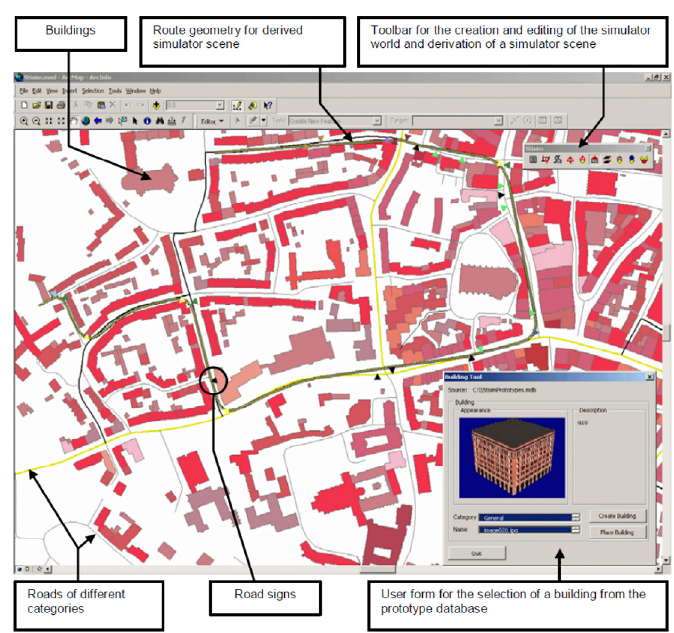
Fig. 4. ArcGIS screen during preparation of spatial data for the STISIM simulator